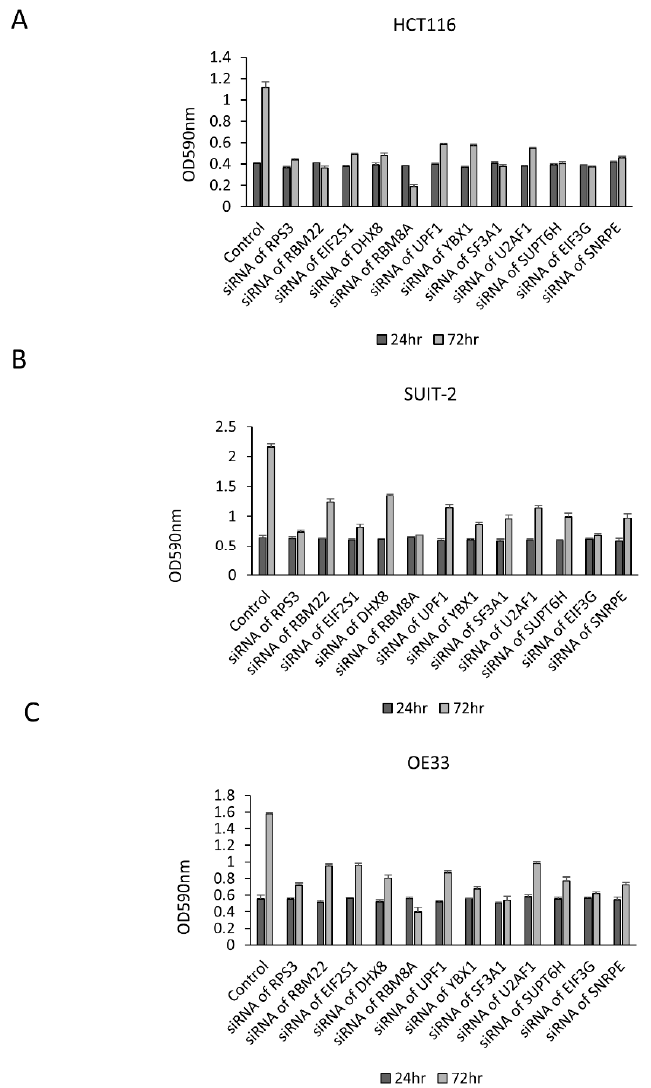
Figure 4. The growth changes by the downregulation of RPS3, RBM22, EIF2S1, DHX8, RBM8A, UPF1, YBX1, SNRPE, SF3A1, U2AF1, SUPT6H, EIF3G in HCT116, SUIT2 and OE33 cells . An MTT assay confirmed the growth suppression effect induced by the downregulation of cancer-related RBPs in HCT116 ( A ), SUIT2 ( B ) and OE33 ( C ) cells.